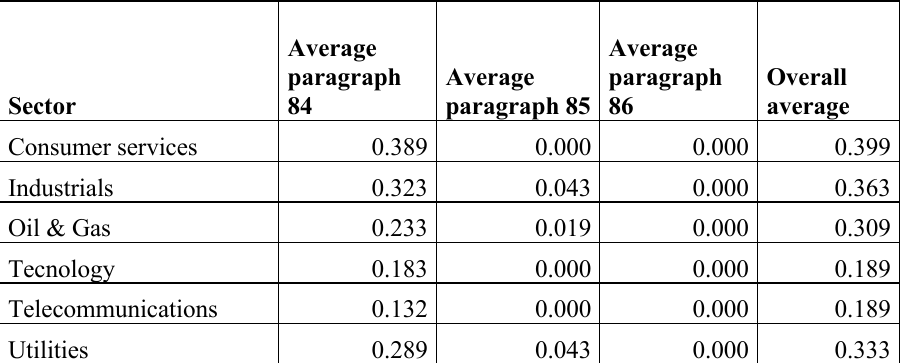
Table 3. “Unweighted” disclosure index by macro sector: year 2016